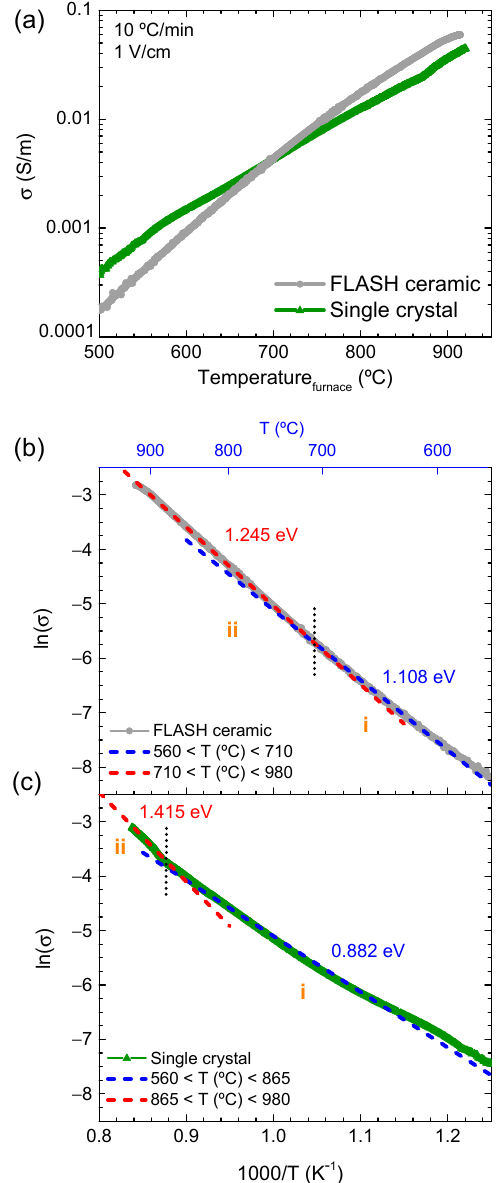
Figure 7. ( a ) DC conductivity vs. furnace temperature and respective Arrhenius plot of ( b ) KNN FLASH-sintered ceramics and ( c ) single crystal, with applied 1 V/cm electric field. The mechanisms of conduction are depicted by the respective activation energies, calculated for specific temperature regimes (i, and ii).